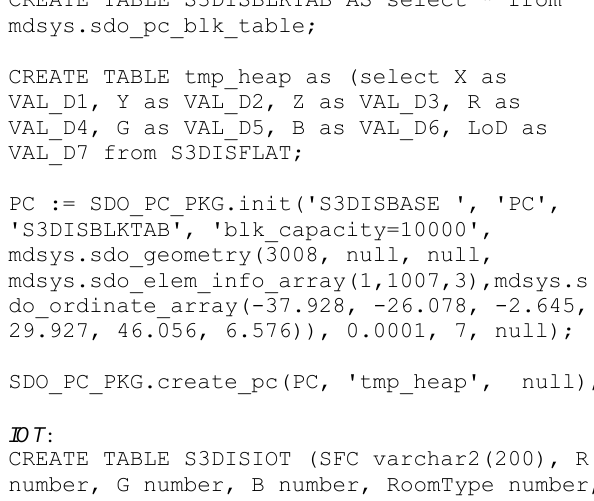
Flat table : CREATE TABLE S3DISFLAT (X number, Y number, Z number, R number, G number, B number, RoomType number, RoomID number, Class number, ObjectID number, LoD number); Nested table : CREATE TYPE Point_type as object (X number,